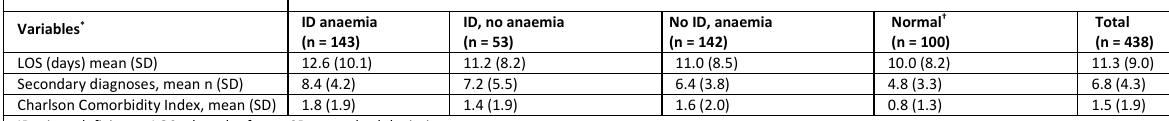
Variables * ID anaemia